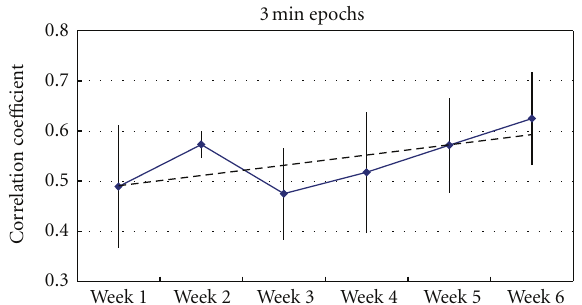
Figure 7: The trend of Pearson correlation coe ffi cients with 3- minute epochs during 6